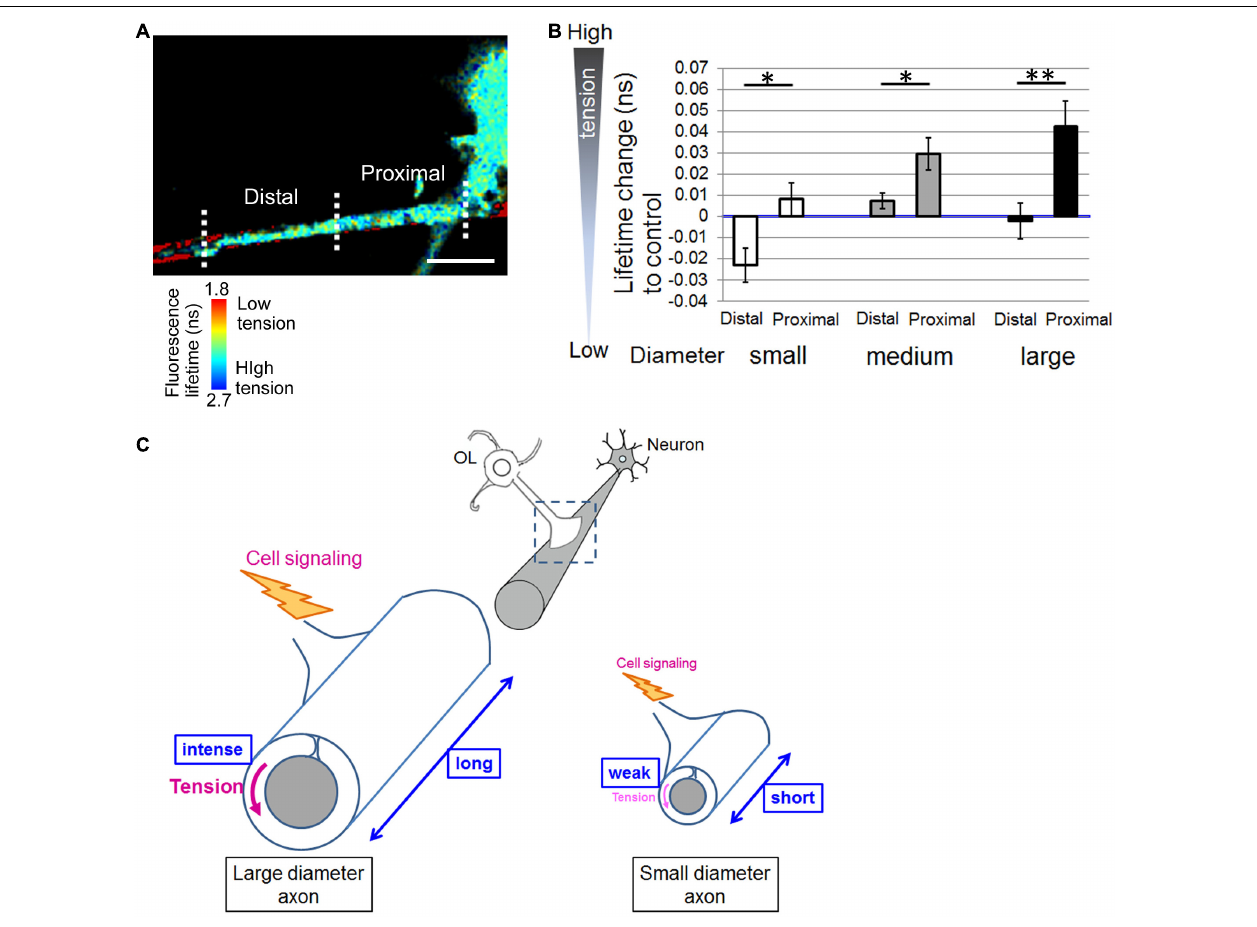
FIGURE 5 | Distal contact points on nanofibers far from the OL processes exhibit lowered tension generation. (A) A representative fluorescence lifetime image of the tension sensor + OL processes exhibiting fiber coverage elongating unidirectionally. Images of the distal contact point and proximal contact point to the OL process are also shown. The distal contact points far from the OL processes exhibited lower tension. Sulforhodamine (red) shows polystyrene nanofibers. Scale bar, 10 µ m. (B) Quantification of average fluorescence lifetime changes relative to the control value in the distal contact points or proximal contact points to each OL process exhibiting unidirectional fiber coverage in small-diameter (0.55–0.9 µ m), medium-diameter (1.5–1.7 µ m) and large-diameter (2.5–4.0 µ m) groups ( ∗∗ P < 0.01, ∗ P < 0.05 proximal values compared with distal values; Student’s t -test, n = 7 areas analyzed for small-diameter fibers, n = 11 areas analyzed for medium-diameter fibers, n = 15 areas analyzed for large-diameter fibers, from four independently prepared cultures established on different days). (C) Schematic drawing of mechanical force generated by OLs contacting neuronal axons with different diameters. Higher tension is generated at OL processes ensheathing larger diameter axons compared with smaller diameter axons, suggesting that physical factors influence myelin formation in response to axon caliber. Additionally, OLs form longer FAs on larger diameter axons and shorter FAs on smaller diameter axons. The proximal FAs near the OL processes showed higher tension, whereas the distal FAs far from the OL processes showed lower tension. This study suggests that intracellular signaling is initiated at FAs, whose size depends on axon diameter, and controls myelin formation involving actin assembly/disassembly.